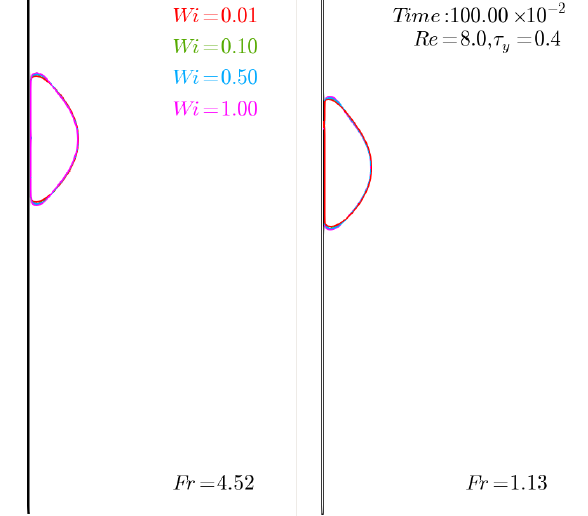
Figure 8. Collision of drops on a vertical wall for fixed values of the Reynolds, Re = 8, and plastic numbers, τ y = 0.4 and the following values of the Weissenberg number, Wi = { 0.01;0.1;0.5;1 } . ( left column ) Fr = 4.52; ( right column ) Fr = 1.13. Dimensionless time, t = 1.